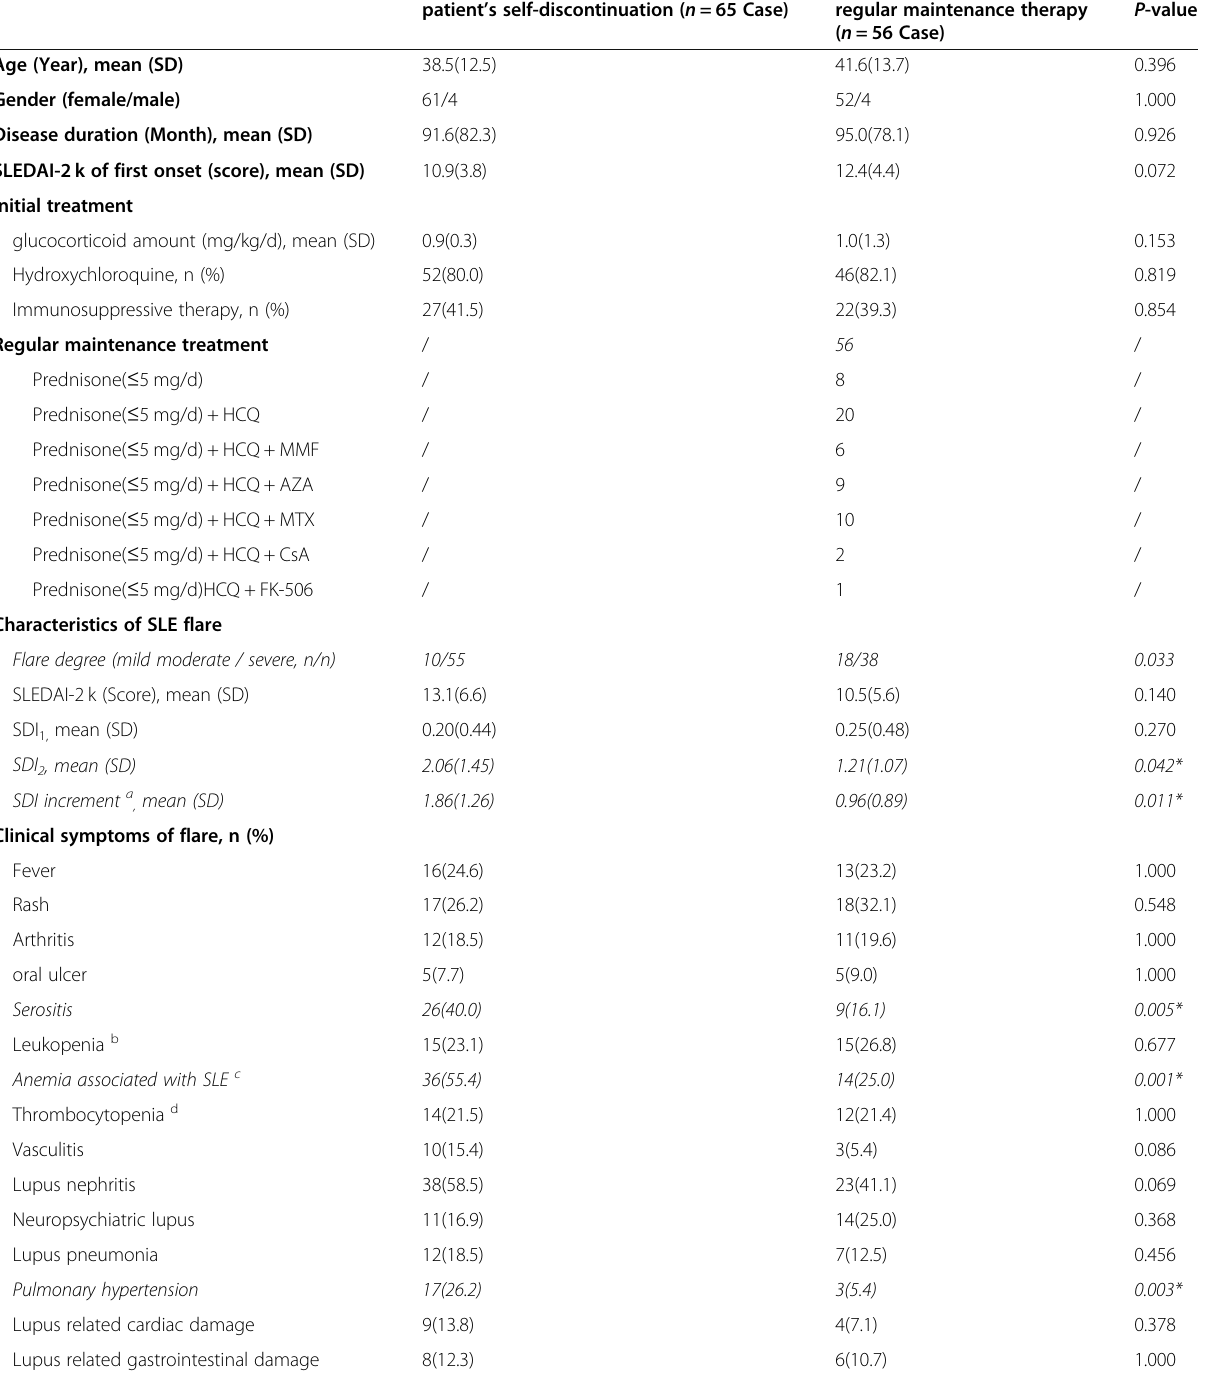
Table 5 The clinical characteristics in patients with SLE